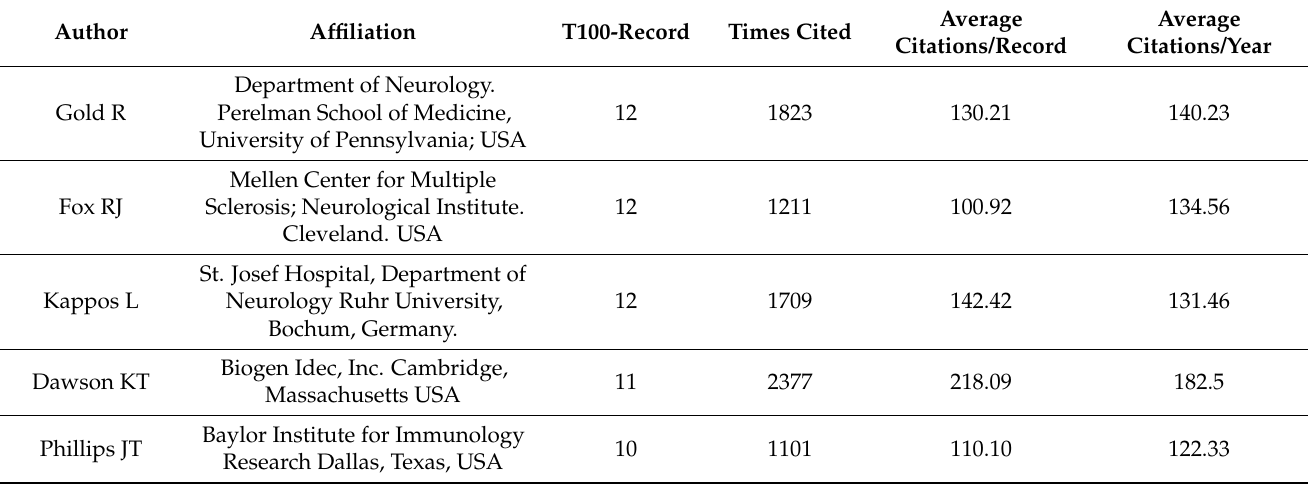
Table 2. Authors with 11 or more T100 articles. Authors are arranged by the number of T100 articles in his/her curriculum (T100-record).